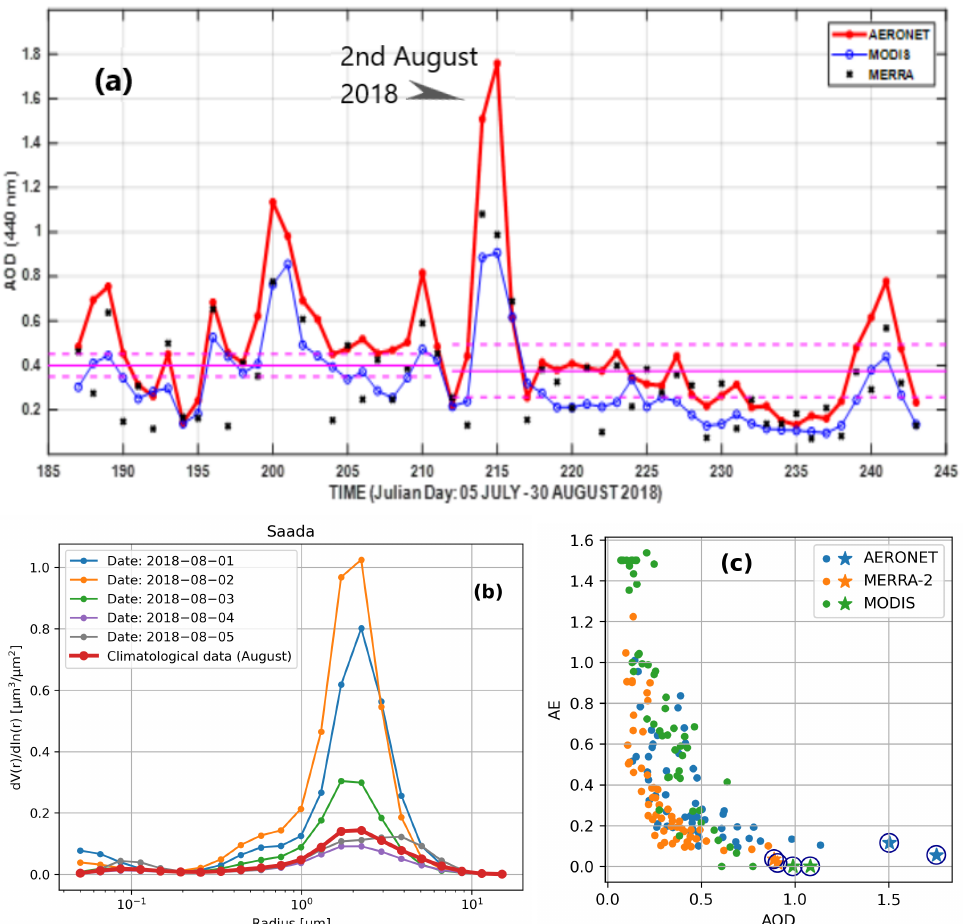
Figure 5. ( a ) Daily averaged aerosol optical depth at 440-nm (AOD 440 ) from sun-photometer (AERONET) at Saada site, together with MODIS (blue line) and MERRA-2 (black cross symbols) values, from 5 July to 30 August 2018. The corresponding monthly seasonal AOD values from AERONET data are superimposed with horizontal lines framed by the ±1 sigma